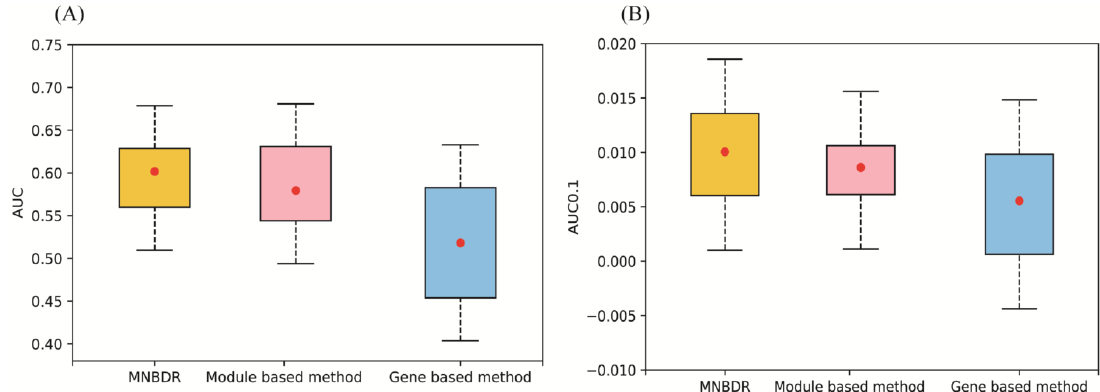
Figure 2. Performance of three different methods. ( A ) AUC. ( B ) AUC0.1. Table 1. The performances of three methods on the 19 cancer datasets.